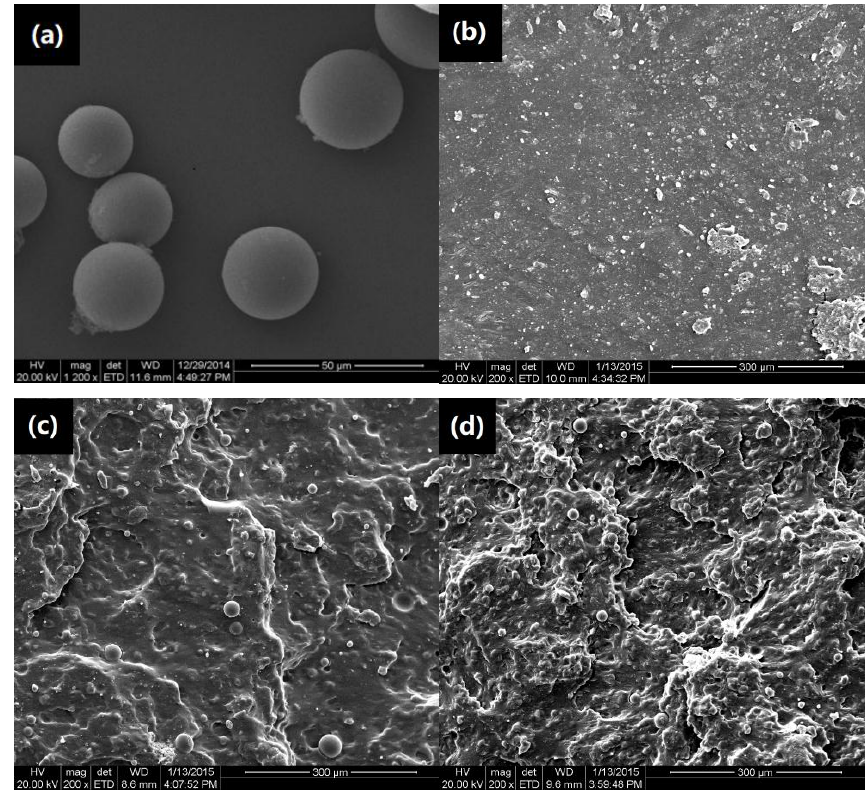
Figure 2. SEM images of PVAMS. ( a ) And the fractured surfaces of PVAMS/TPS composites with PVAMS content of ( b ) 0 (TPS); ( c ) 1; ( d ) 2 wt %.